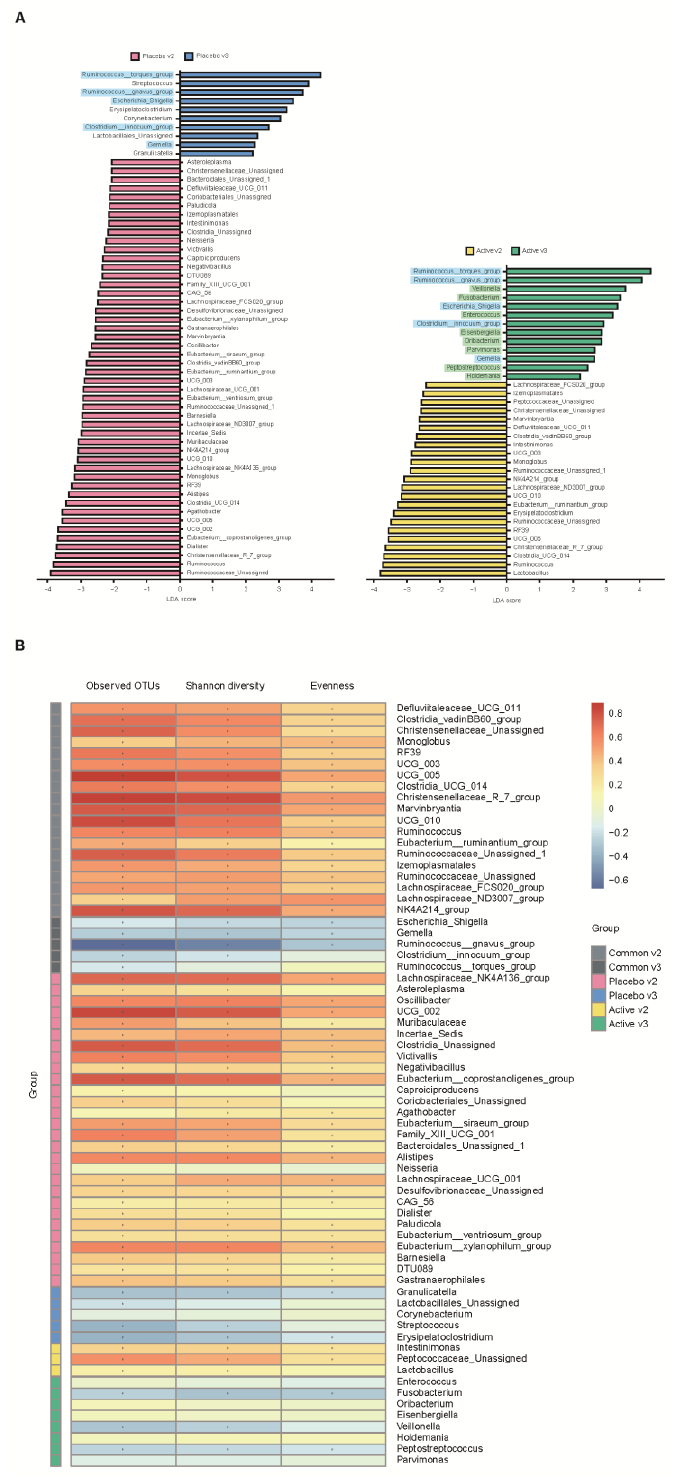
Figure 5. Comparative analysis of the 2nd and 3rd visit groups. ( A ) Microbiome analysis via linear discriminant analysis (LDA) effect size (LEfSe) at the genus level. The bar size represents the effect of specific taxa number in the particular group at the genus level. The alpha value for the factorial Kruskal–Wallis test was <0.05 and the threshold on the logarithmic LDA score for discriminative feature was >2.0. ( B ) Heatmaps indicate positive (red) and negative (blue) correlations between the alpha diversity and the taxa sorting in the results of LEfSe. The figure is drawn by sorting the taxa based on the result in ( A ). * p < 0.05 (Spearman’s correlation).